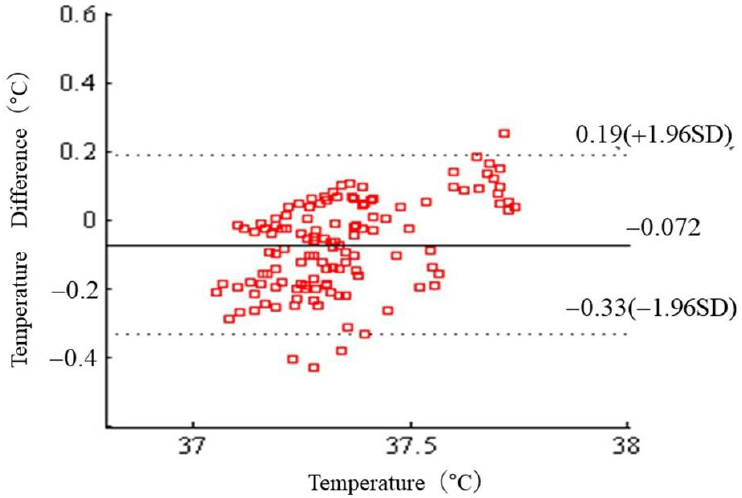
Figure 11. Bland–Altman plot of DBT during the exercise and recovery periods. Difference between ZHFT and DHFT measurements of DBT on the forehead.